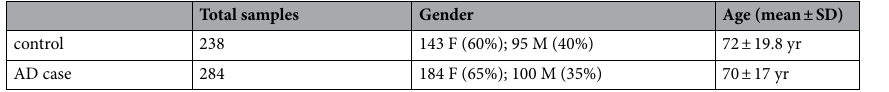
Table 1. AddNeuroMed dataset. AD, Alzheimer’s disease; F, Female; M, Male; sd, standard deviation; yr,